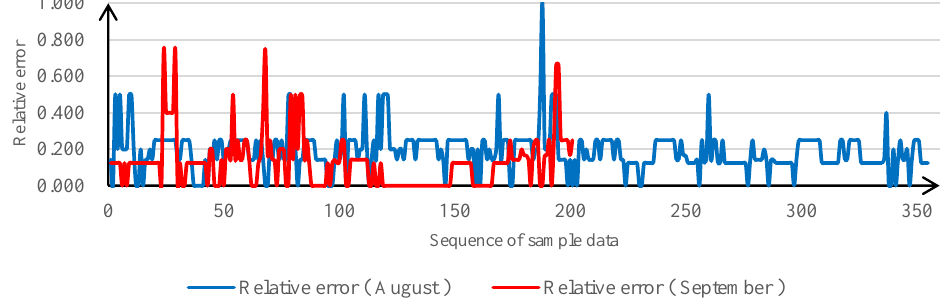
Figure 6. The relative error of referred Vis from Equation (4) against observations obtained from the Chinese Ninth Arctic Science Examination (CNASE).